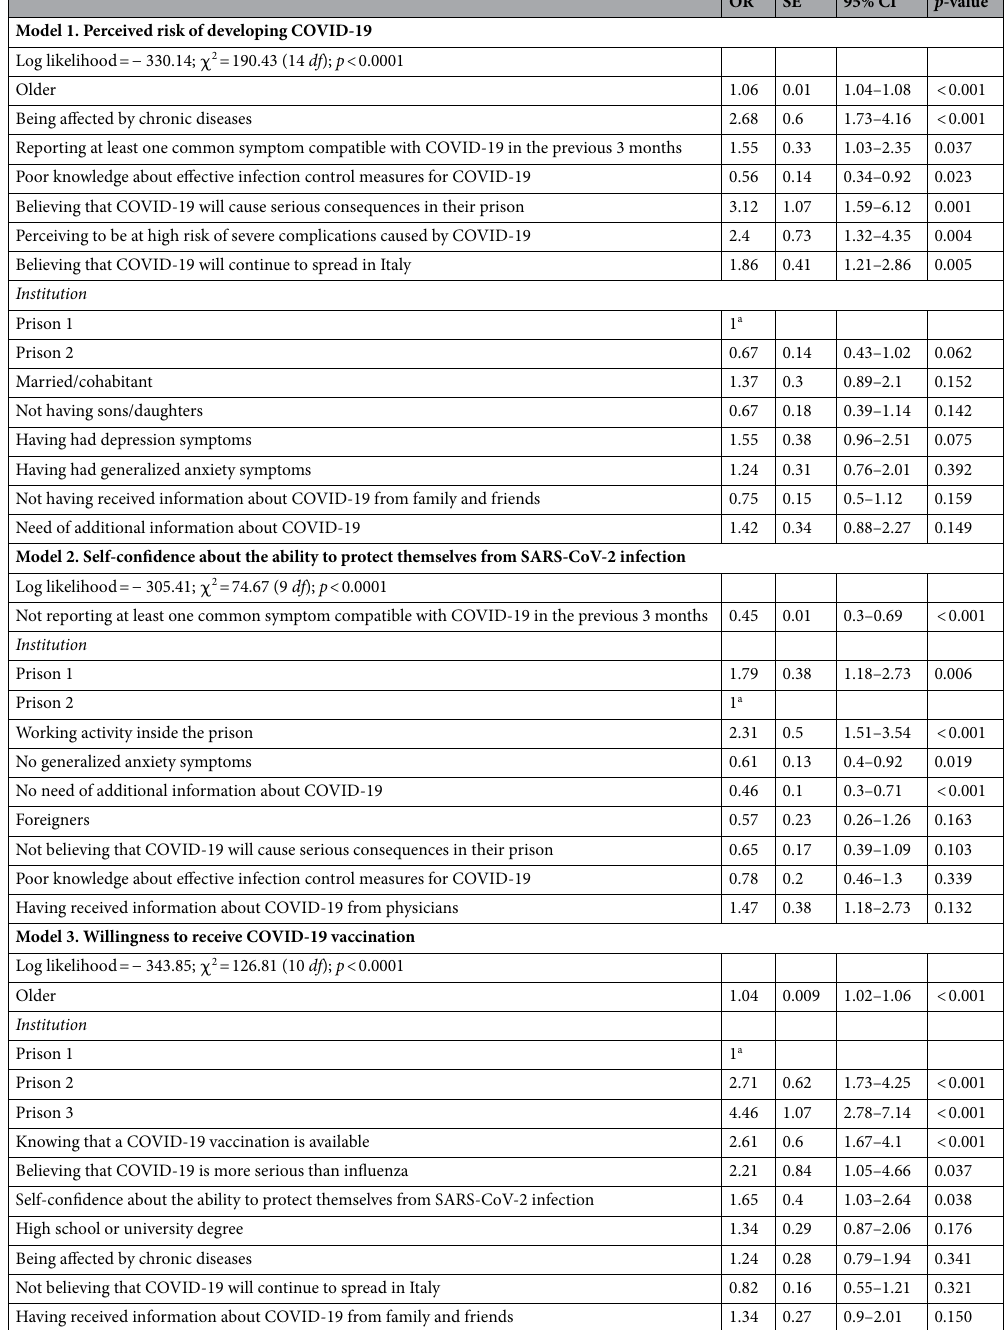
Table 4. Multivariate logistic regression analyses to characterize factors associated with the outcomes of interest. a Reference